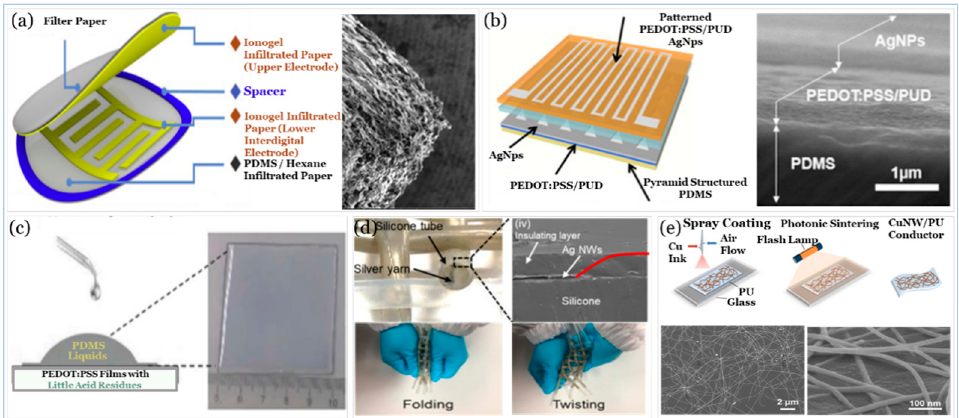
Figure 18. Sensor electrodes. a) Nanocomposite electrode. Reproduced with permission. [321]